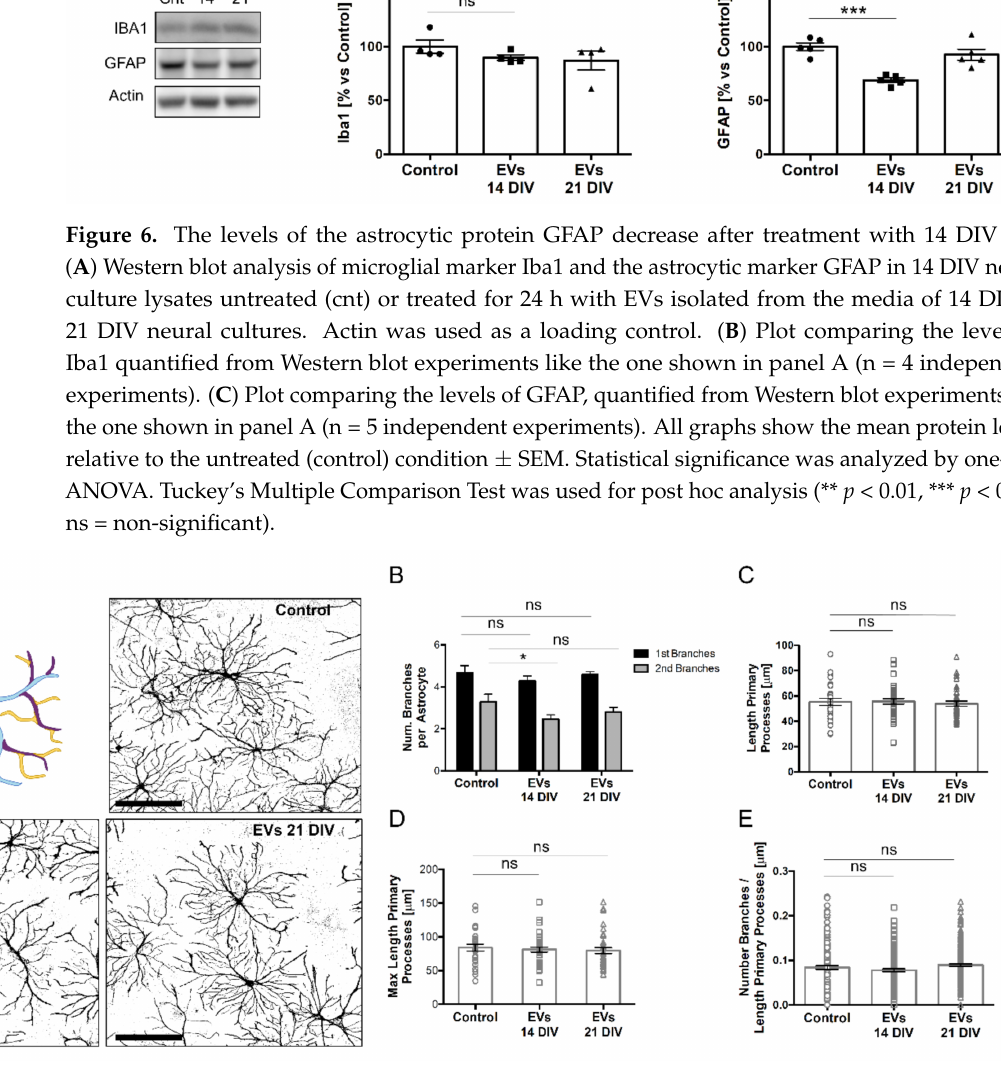
Figure 7. Inflammatory effect of 14 and 21 DIV isolated EVs on 14 DIV neural cultures. ( A ) Rep- resentative confocal images of astrocytic processes, detected with an antibody against GFAP, of 14 DIV neural cultures untreated (control) or treated for 24 h with EVs isolated from the media of 14 DIV (EVs 14 DIV) or 21 DIV (EVs 21 DIV) neural cultures. A scheme highlighting the primary processes, primary branches, and secondary branches of astrocytes is shown on the left upper quad- rant of this panel. 14 DIV neural cultures untreated (control) or treated for 24 h with EVs 14 DIV or EVs 21 DIV, were analyzed for the number of primary and secondary branches per astrocyte (bar = 100 µ m) ( B ), the length of primary astrocytic processes ( µ m) ( C ), the maximum length of the primary astrocytic processes ( µ m) ( D ) and the density of the branches on the main processes (number of primary branches normalized to the length of the primary astrocytic processes (num/ µ m); panel ( E ). All graphs show mean values ± SEM. Statistical significance was analyzed by one-way ANOVA. Tuckey’s Multiple Comparison Test was used for post hoc analysis (* p < 0.05, ns = non-significant; n = 3 independent